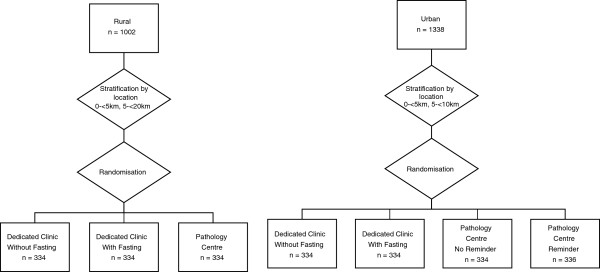
Protocol for allocation of study participants to groups.